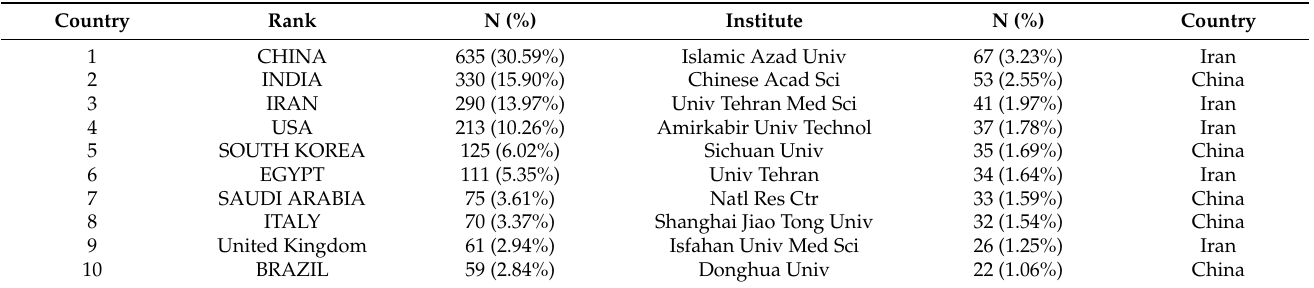
Table 2. The top 10 countries and institutions contributed to publications of nano-drug release research in wound healing [n